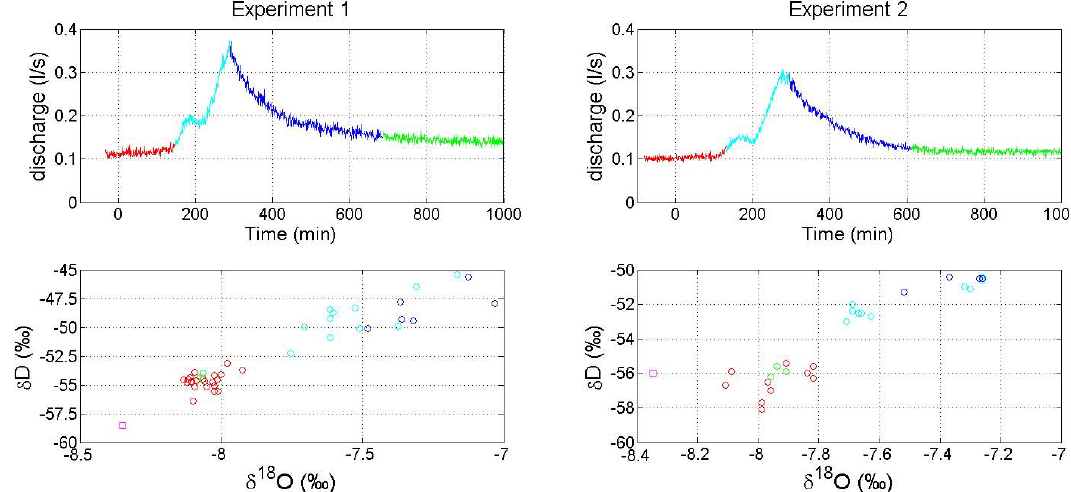
Fig. 8. Correlation between hydrograph phases and isotopic composition of tile-drain water. Left column are the results of the first experiment and the right column for the second experiment. Magenta denotes the isotopic composition of the irrigation water, light blue the isotopic composition of the rising hydrograph limb, dark blue the isotopic composition of the falling hydrograph limb, red the isotopic composition of baseflow conditions, and green the isotopic composition after the